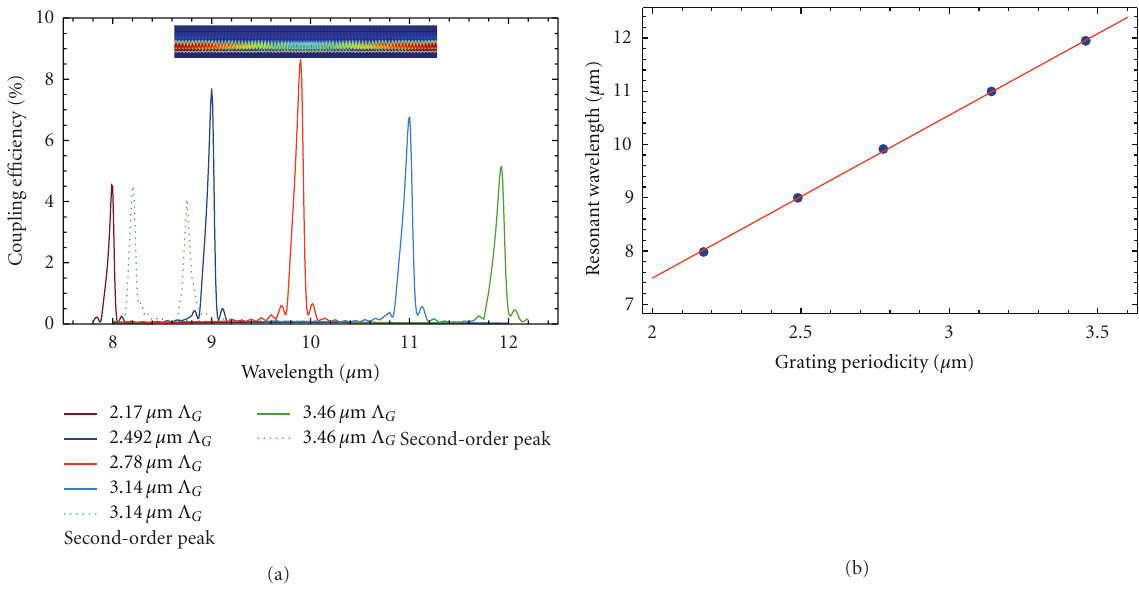
Figure 2: (a) Comparison of coupling e ffi ciency spectra for several di ff erent grating periodicities. The coupling e ffi ciency is defined as the fraction of the total incident power that leaves the grating in one direction. Dotted lines indicate second-order peaks. Inset is a plot of the time averaged power flow (magnitude of the Poynting vector) for a grating resonant at 11 μ m. The aspect ratio is expanded vertically by 6x for better visibility. (b) Resonant wavelength for several di ff erent grating periodicities. Parameters used: t Ge = 1 . 65 μ m, t ZnSe,2 = 200nm, t = 200nm, d G = 100nm, N G = 80. Al